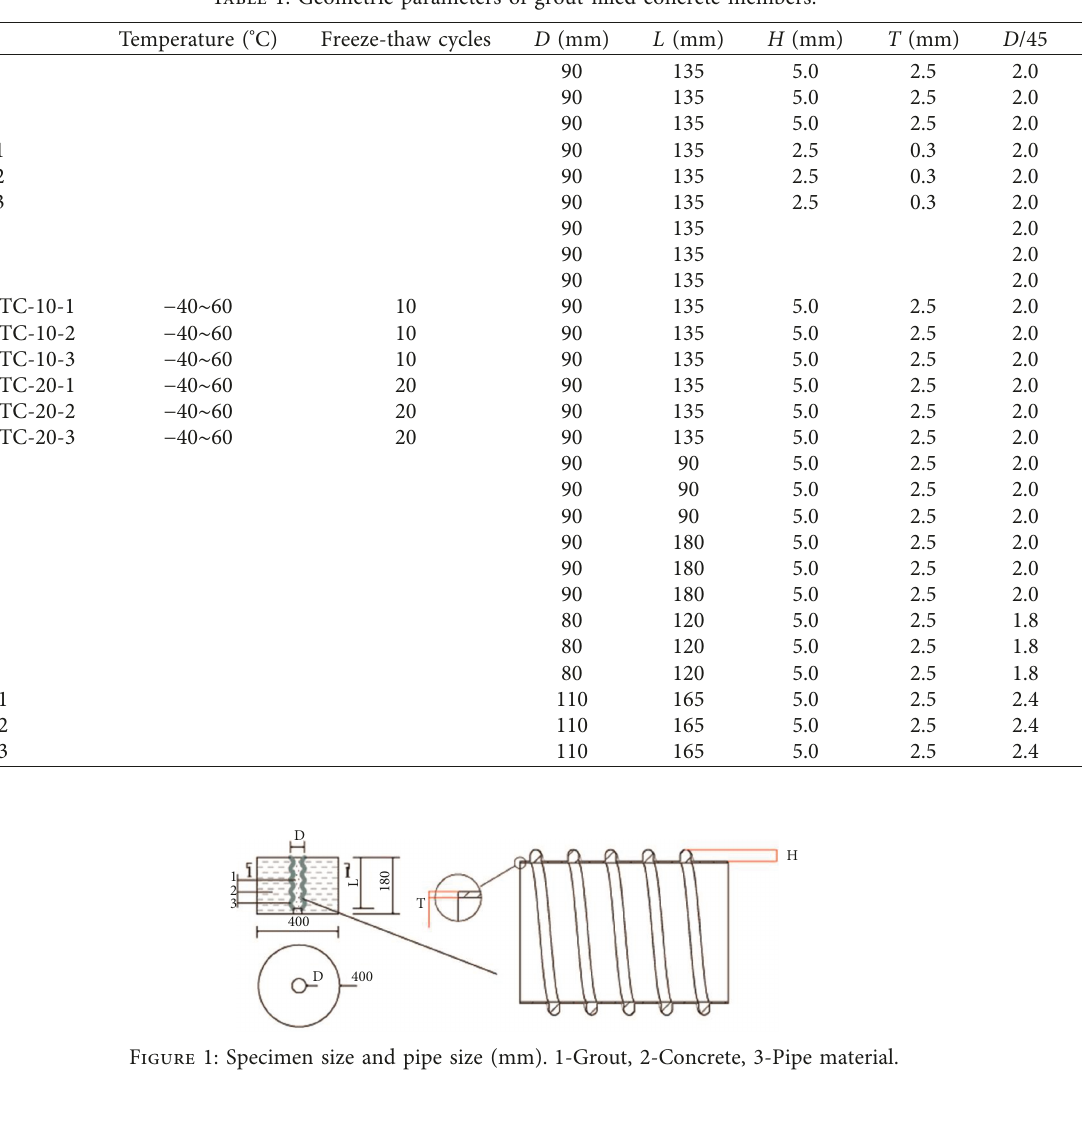
Table 1: Geometric parameters of grout-filled concrete members.